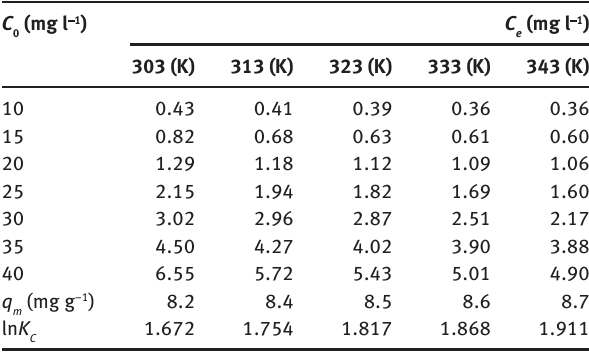
Table 5: Thermodynamic parameters of fluoride adsorption onto RHA/Al(OH) 3